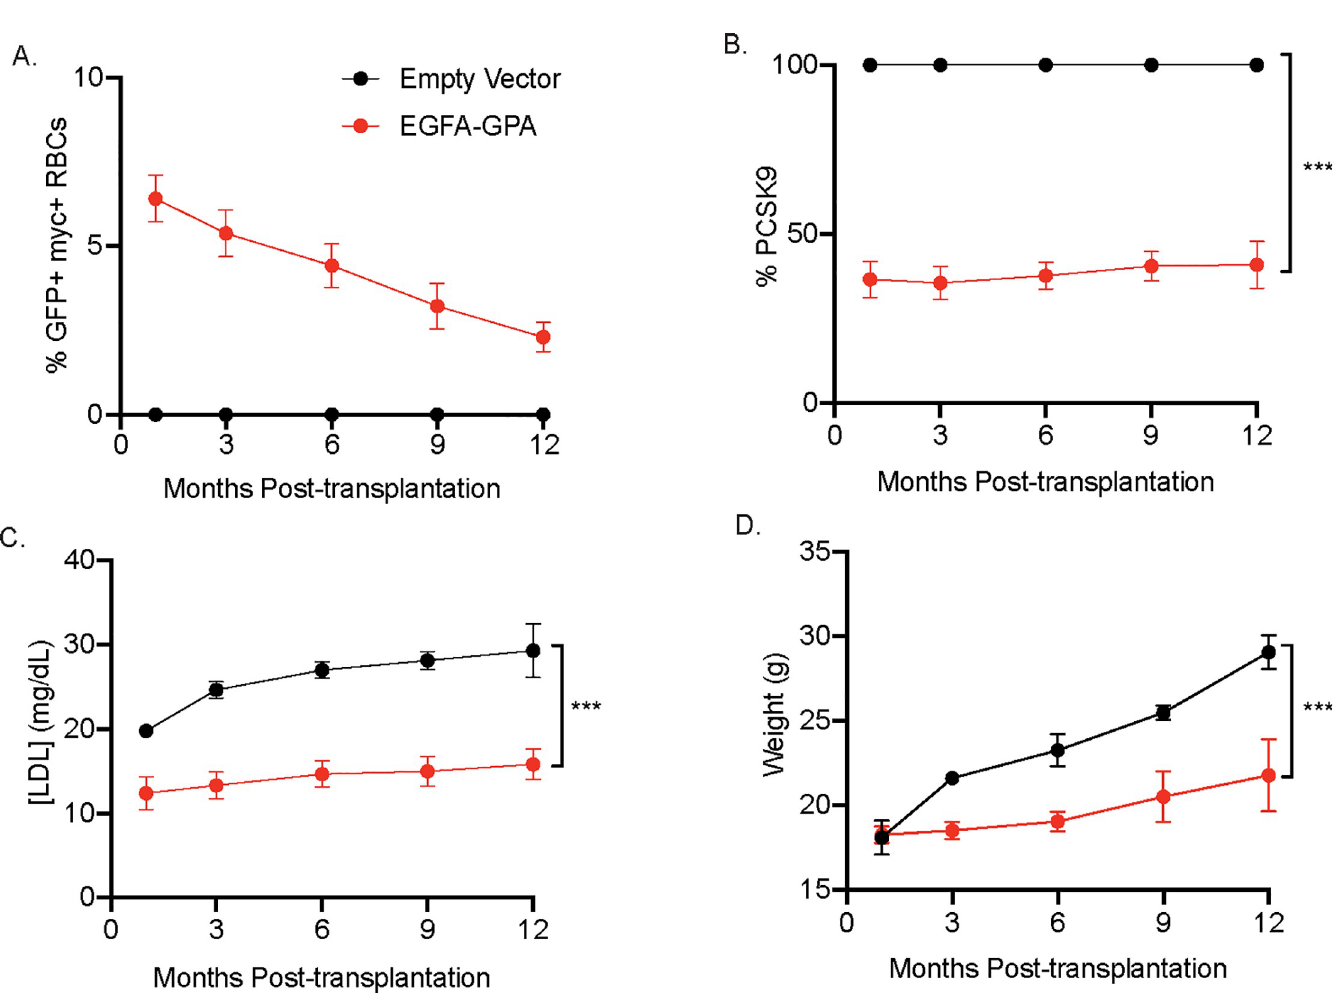
Fig 3. EGFA-GPA—Expressing mice maintain lower plasma LDL level and weight for the remainder of their lifetime. (A) Long-term expression of myc+ cells (n = 12, mean ± SEM) in mice transplanted with HSPCs expressing the Glycophorin A- EGF-A chimeric protein. (B) Plasma PCSK9 and (C) LDL levels of transplanted mice were quantified via ELISA assay at the indicated time points. Engineered RBCs act as a sink in capturing circulating PCSK9 molecules, inhibiting LDLR degradation that resulted in lower plasma LDL concentration. (n = 8/group, mean ± SEM). (D) Mice expressing EGFA-GPA RBCs weigh significantly less than control mice throughout their observed lifespan (n = 8/group, mean ± SEM).